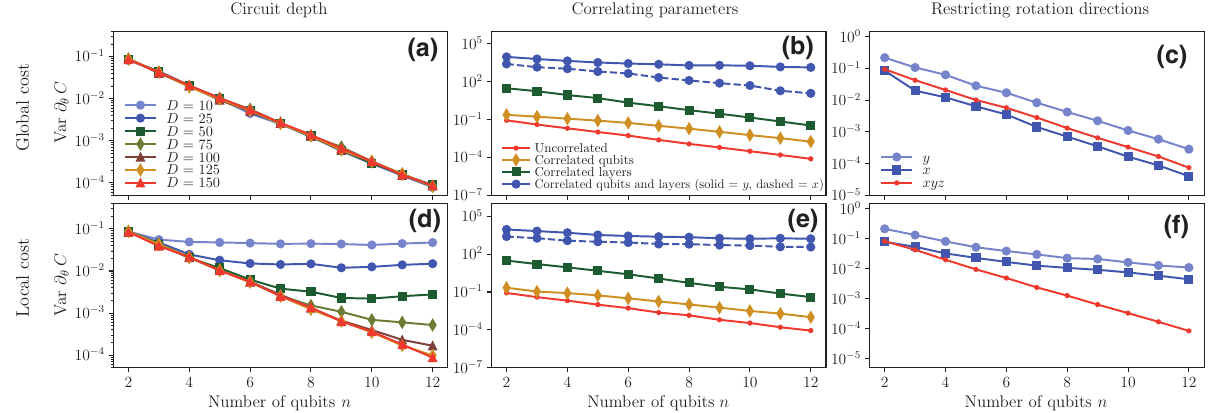
FIG. 3. Partial-derivative scalings for different expressibilities. The variance in the partial derivative of a global cost with H G = (cid:10) n σ z σ z (top) and 2-local cost with H L = σ z (bottom) as a function of the number of qubits n . In both cases ρ = | ψ 0 (cid:7)(cid:8) ψ 0 | ⊗ n where i i = 1 1 2 | ψ (cid:7) = exp[ − i (π/ 8 )σ | 0 (cid:7) . In the left panel, we vary the circuit depth D of a hardware-efficient ansatz. In the middle (right) panel, we 0 Y ] consider the effect of correlating parameters (restricting the directions of rotation) of a hardware-efficient ansatz with D = 150, with the choices of correlations (rotations) indicated in the figure legend. In all cases, the derivative is taken with respect to θ 1 angle of the first qubit in the first layer, and the variance is taken over an ensemble of 1000